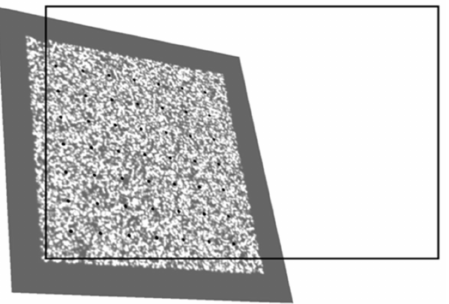
Figure 5. Taking an image of the speckle pattern calibration target.